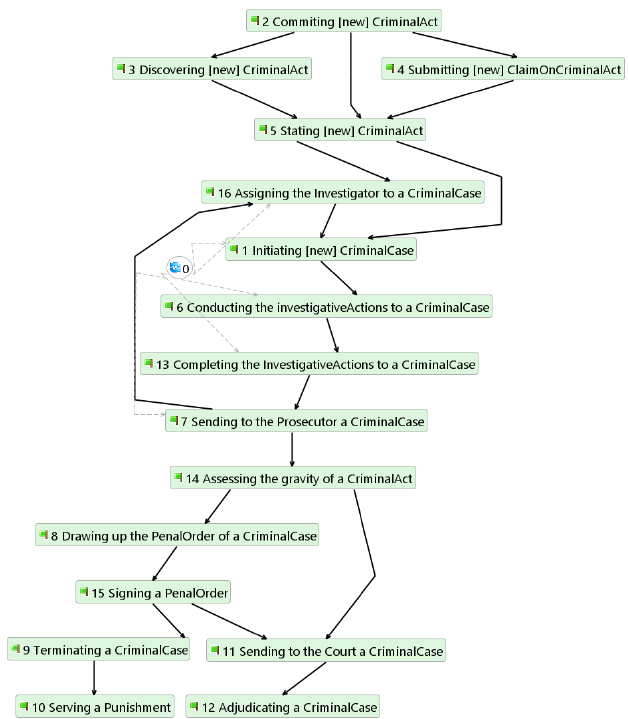
Fig. 3. The topological space obtained from the facts in the frame